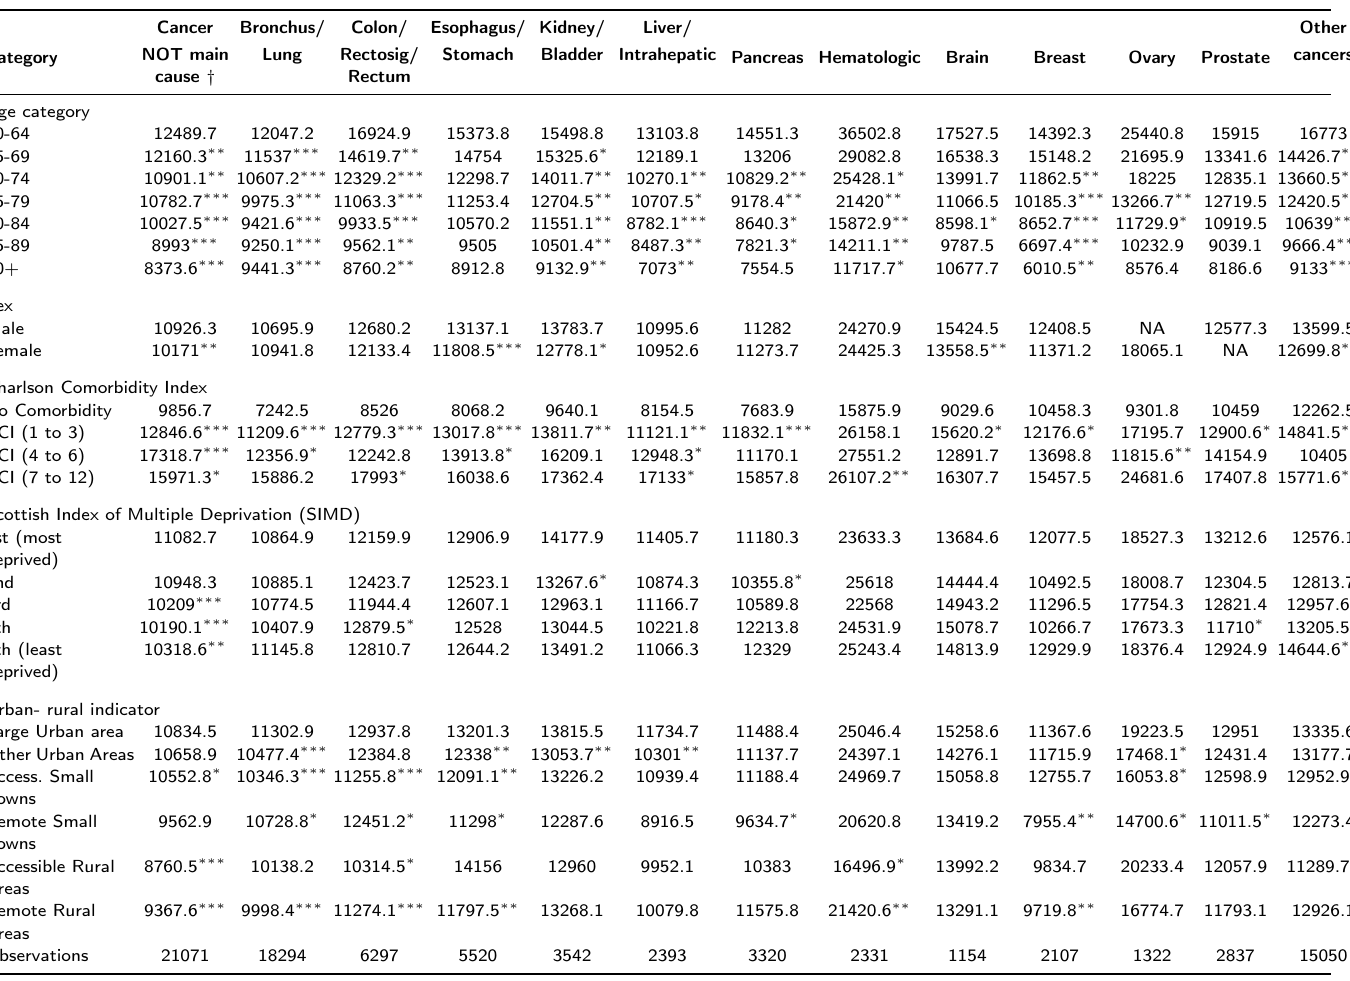
Table 4: Generalised linear model results presented for “cancer not being the main cause of death” and all cancer types in- costs ( £